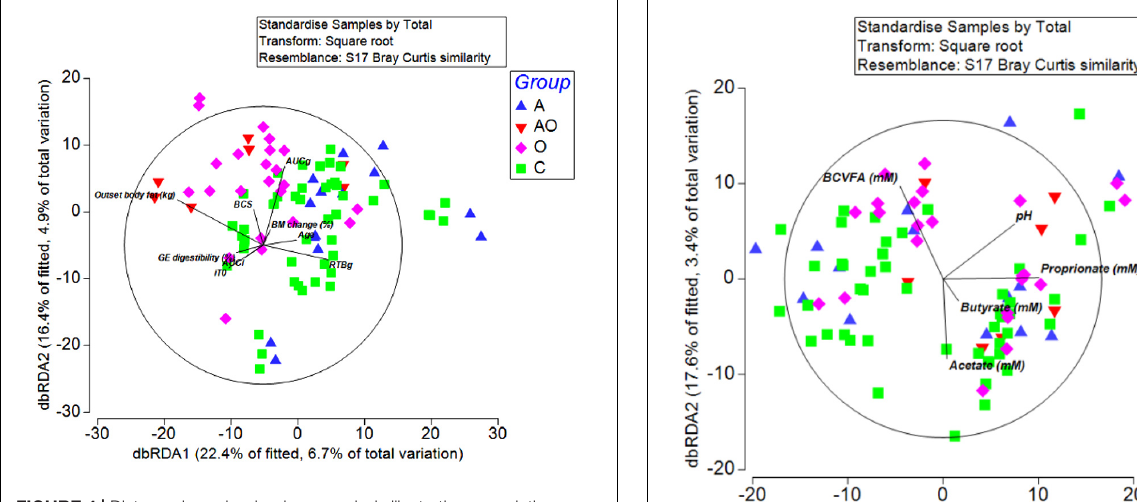
FIGURE 4 | Distance-based redundancy analysis illustrating associations between the fecal microbiome of Aged (A), Aged and Obese (AO), Obese (O), and Control (C) animals and outset host phenotype measures; Apparent digestibility of gross energy (GE digestibility), body condition score (BCS), areas under the curves for insulin (AUCi) and glucose (AUCg), and the time taken for glucose concentrations to return to baseline (RTBg) during a combined glucose/insulin tolerance test, outset body fat (kg), age (years), and percentage changes in body mass across the 4 week hay feeding periods [BM change (%)].